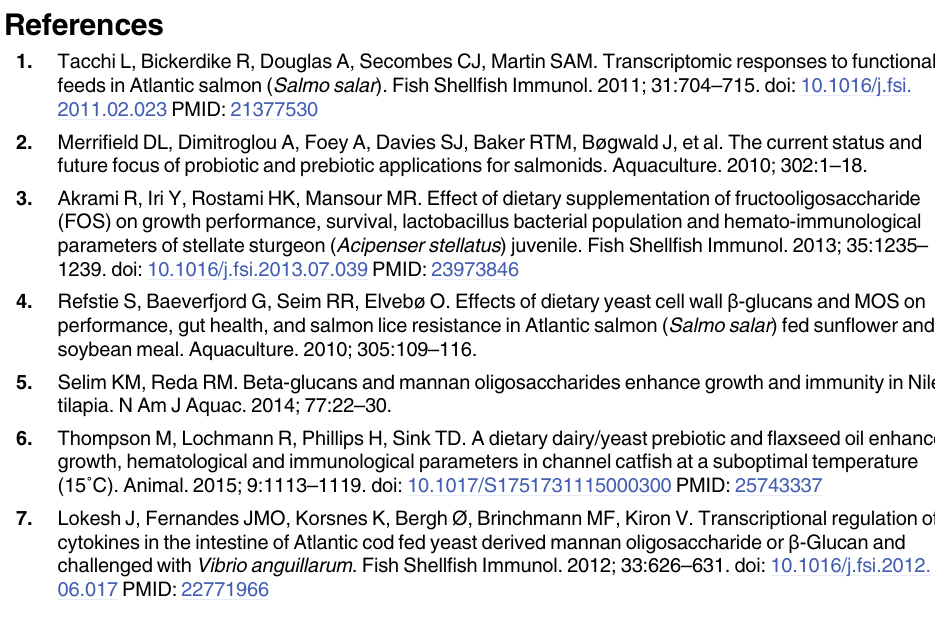
S1 Table. Details of diets used in Trials #1 and #2.